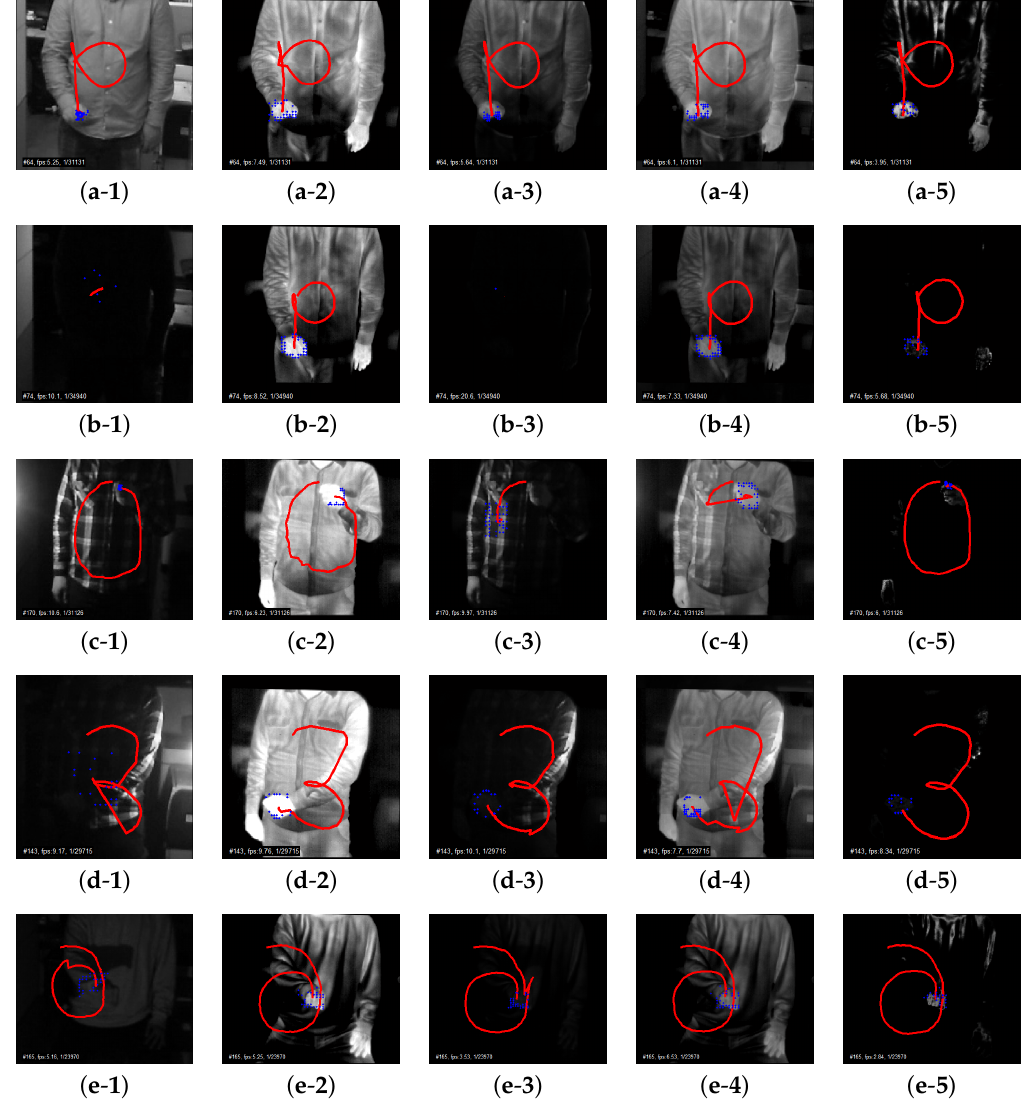
Figure 5. Example results of ( 1 ) V (Visual); ( 2 ) T (Thermal); ( 3 ) V ∗ T (multiplication-based visual–thermal fusion method); ( 4 ) V + T (addition-based visual–thermal fusion method); and ( 5